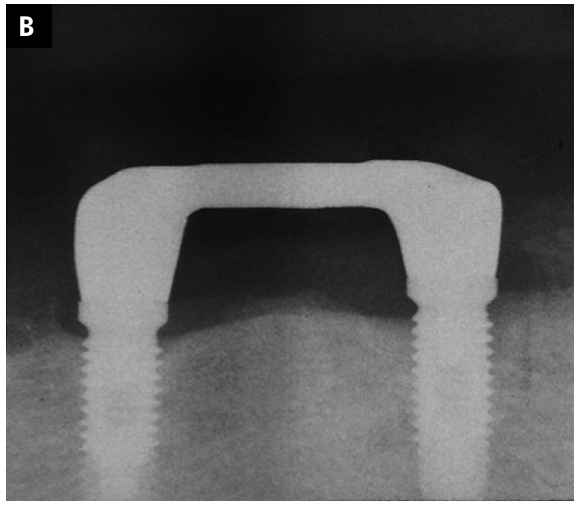
Figure 1B. Radiographic view at the 48-month